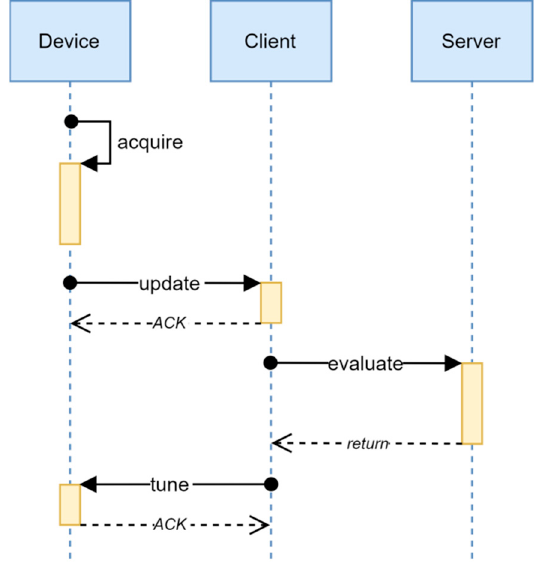
Figure 3. The distributed calibration method diagram.